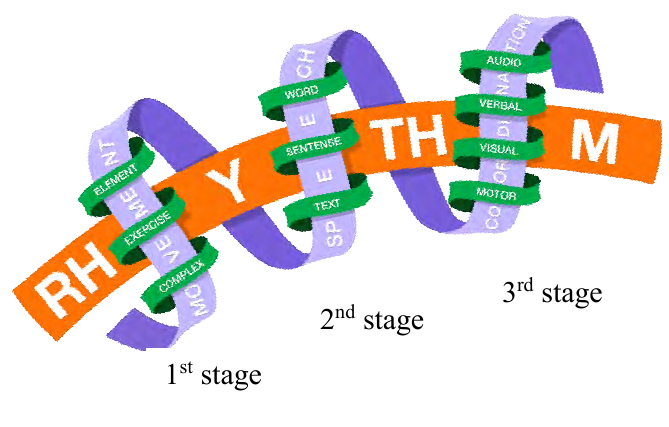
Fig. 3. The Conceptual Model formation of rhythmic-structures activity of the specialist of Physical